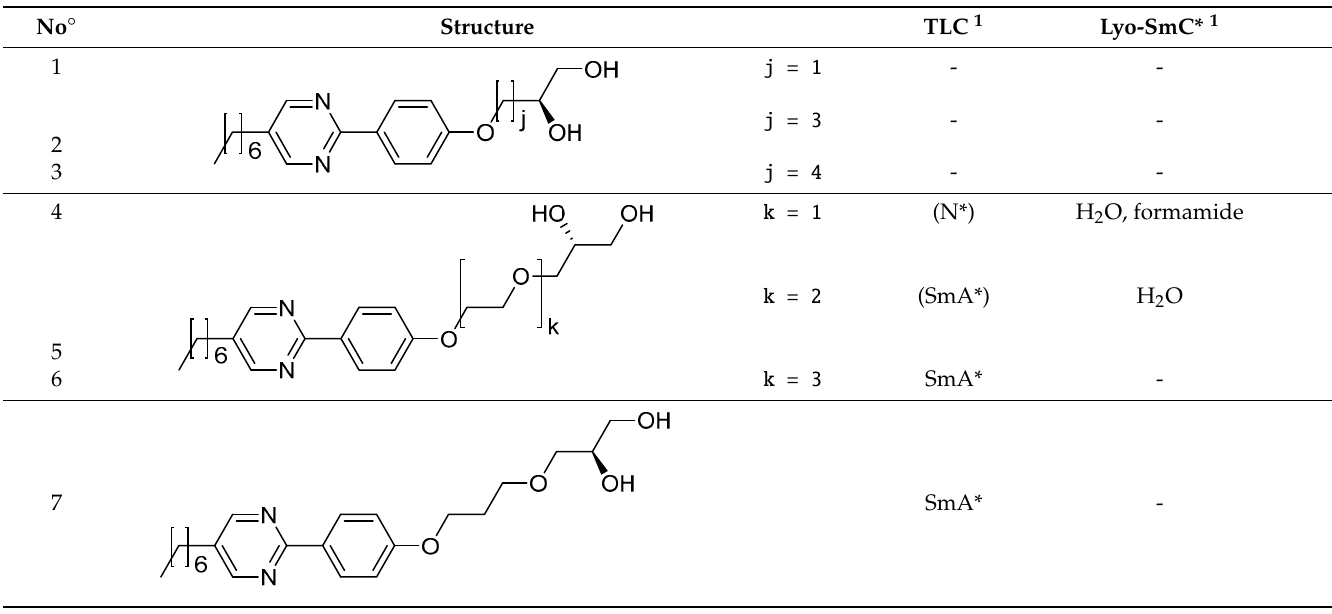
Table 1. Summary of the amphiphiles which were screened for the lyotropic SmC* phase. Thermo-tropic liquid crystalline (TLC) phases that occur are listed, as are solvents tested during screening which enable the formation of a lyotropic SmC*